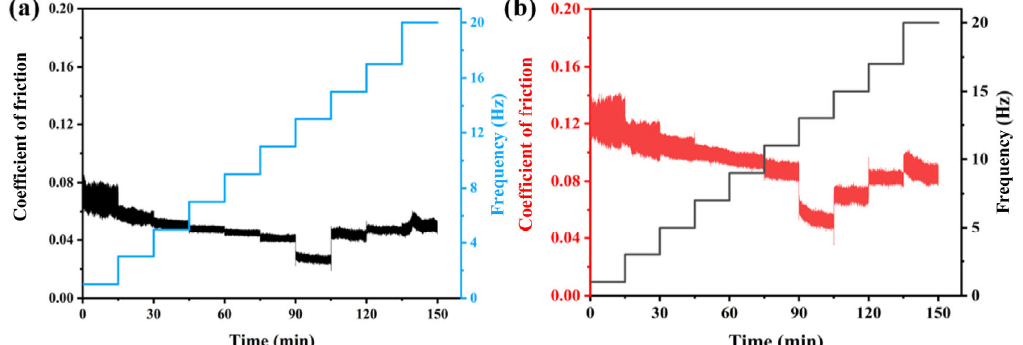
Fig. 10 Evolution of COF with time during a frequency ramp test from 1 to 20 Hz (load = 10 N, and the frictional test lasted 150 min) for (a) OCHPPI-T100 and (b)